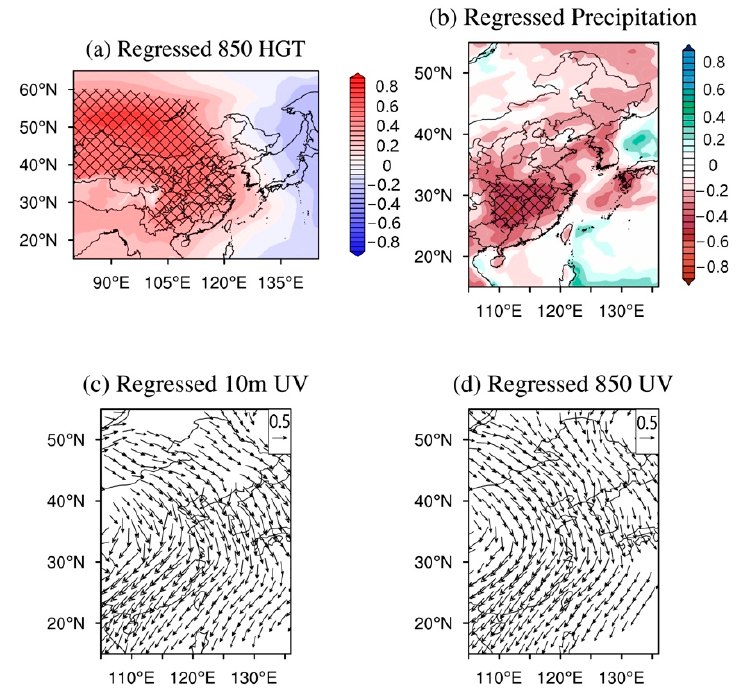
Figure 8. Regressed 850 hPa geopotential height ( a ), precipitation ( b ), surface wind at 10 m ( c ), and 850 hPa wind ( d ) on the AQI PC2. The black crosses in panel ( a , b ) represent the region with regression significant at a 99% confidence level, shown in panel ( c , d ) are only wind vectors that are significant above a 99% confidence level.